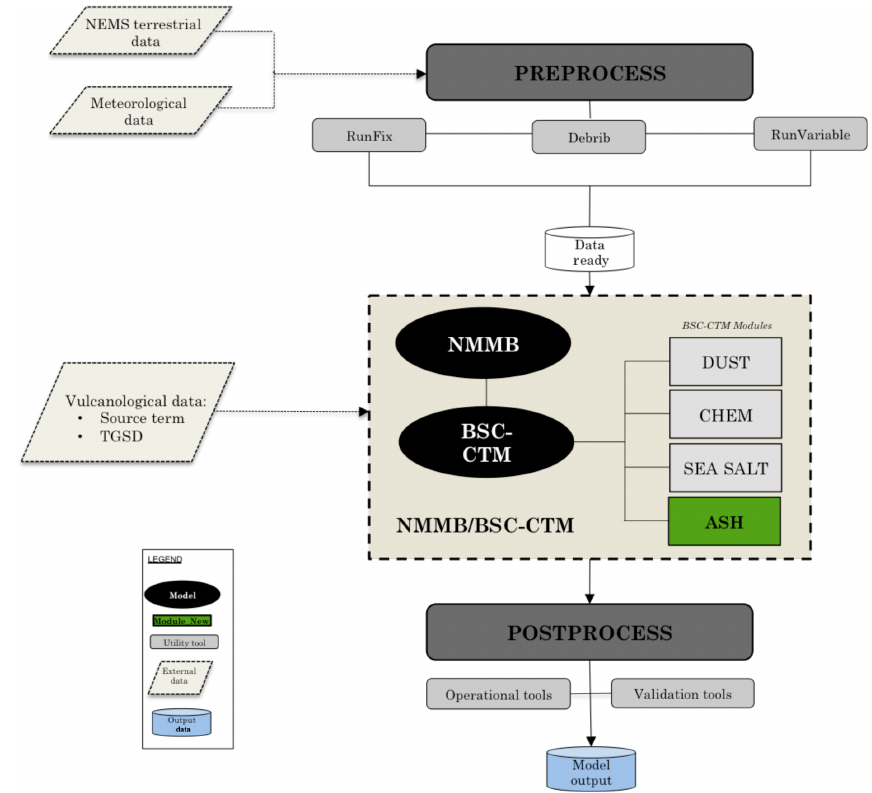
Figure 11. Schematic representation of the operational implementation of NMMB-MONARCH-ASH.